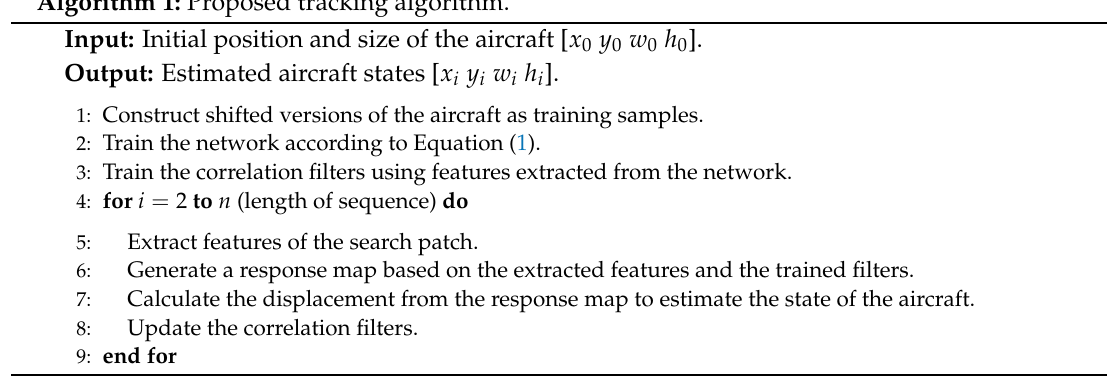
Algorithm 1: Proposed tracking algorithm.